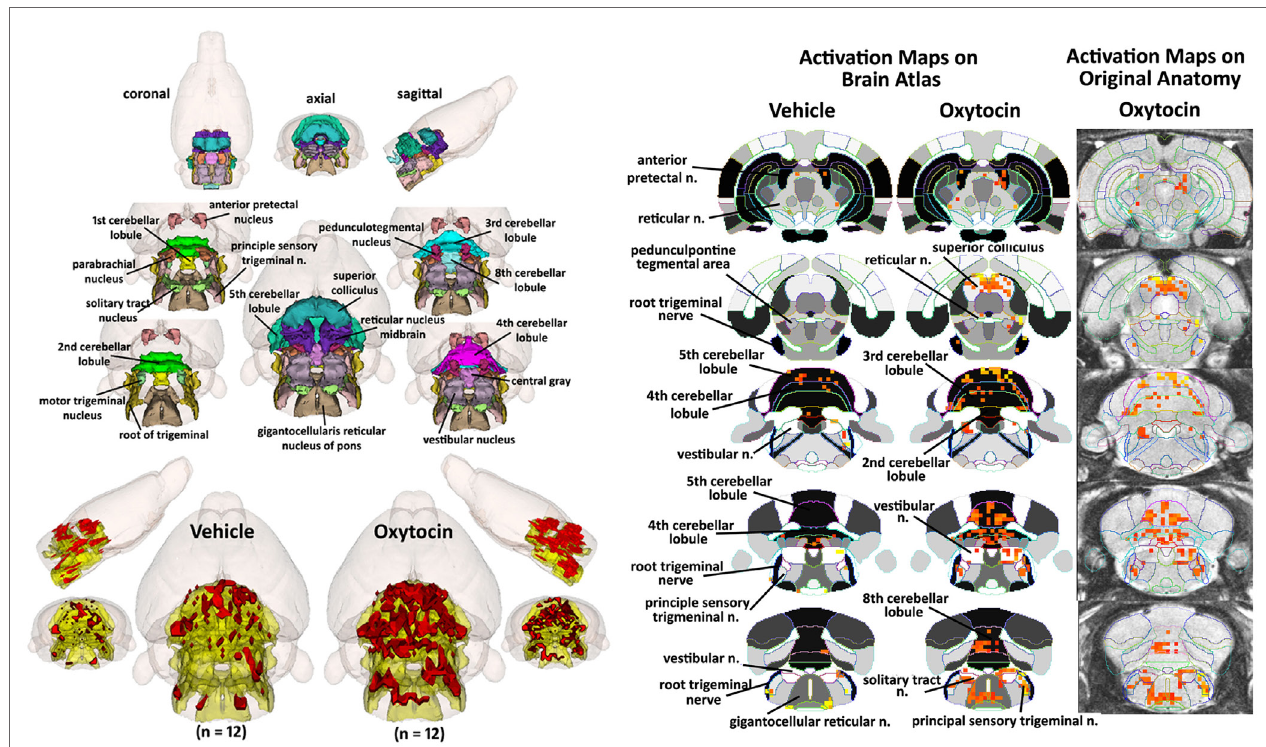
FigUre 7 | hindbrain areas activated by intraperitoneal oxytocin . The 3D color model at the top left depicts the location of brain areas associated with activation of sensory afferents coming from the autonomic nervous system and synapses at the level of the brainstem and cerebellum. These areas have been coalesced into a single volume (yellow) as shown in the lower 3D images for IP vehicle ( n = 12) and OT ( n = 12). Areas in red are the localization of the activated voxels comprising the composite average from the rats in each experimental group following IP OT (2.5 mg). To the immediate right are 2D activation maps from the rat brain atlas showing the precise location of the significantly activated positive (red) voxels. The images to the far right show the localization of the voxels on the original neuroanatomical